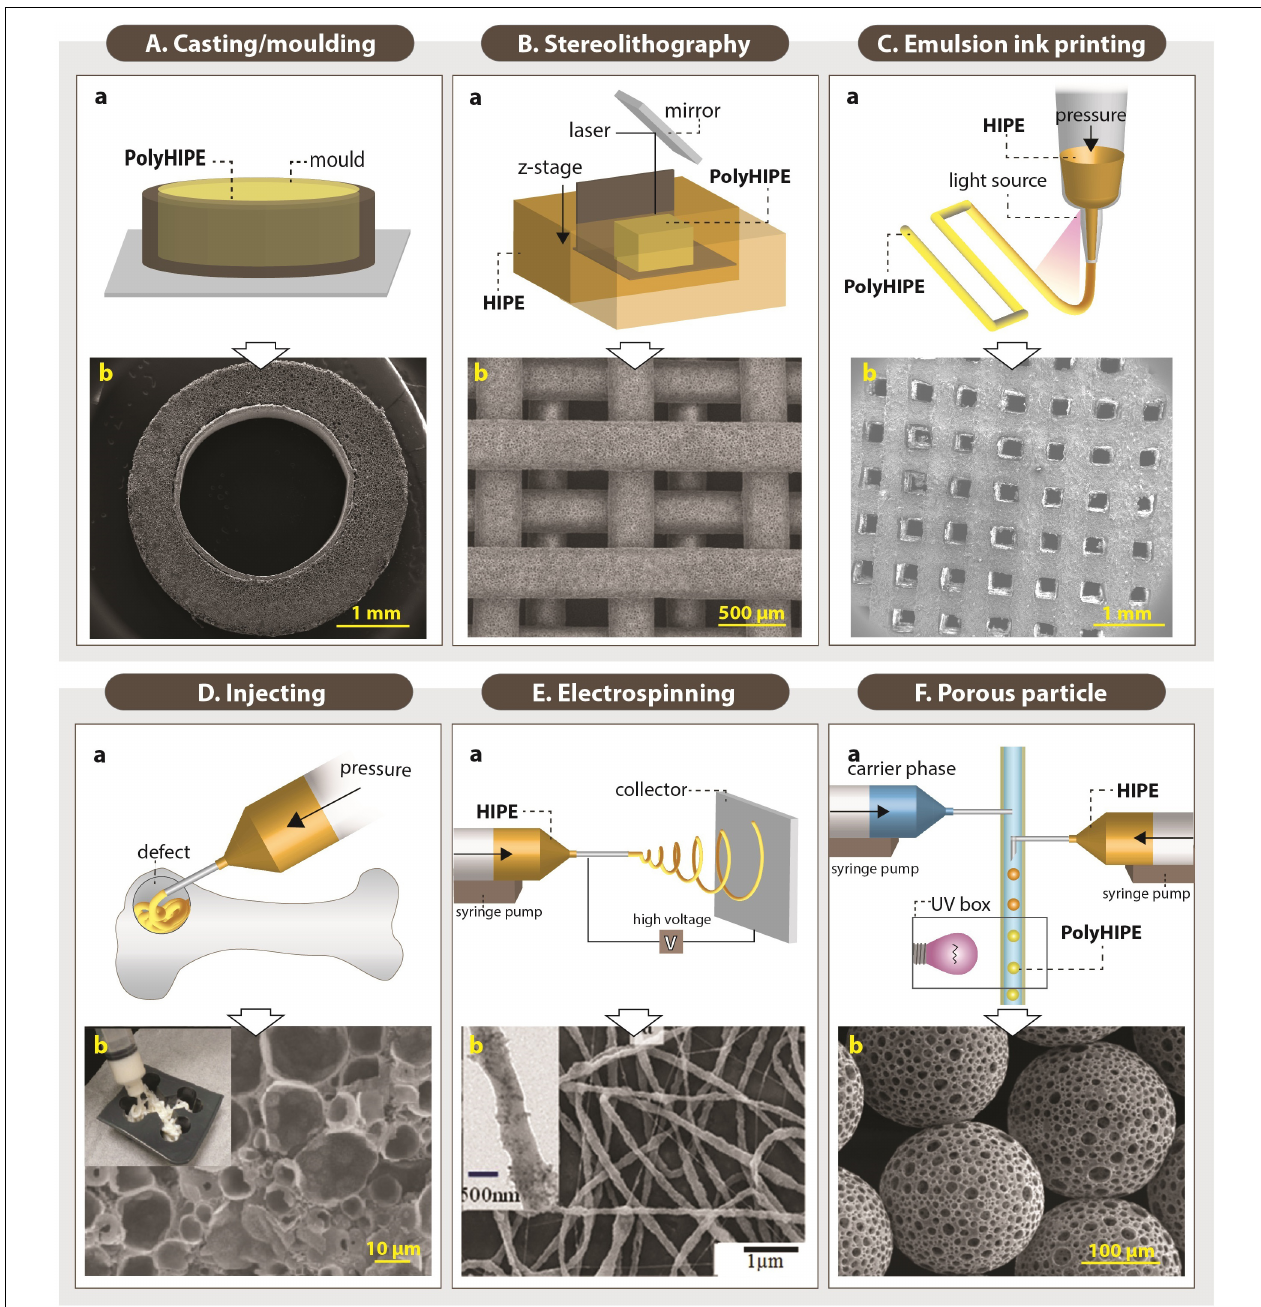
FIGURE 10 | Setups of various fabrication routes of emulsion templated scaffolds (Aa,Ba,Ca,Da,Ea,Fa) , and scanning electron microscopy images of these scaffolds (Ab,Bb,Cb,Db,Eb,Fb) . (Original images were cropped, and scale bars were added to enhance the figures). Images (Ab,Bb,Cb,Fb) were adapted from Dikici et al. (2020a), Owen et al. (2016), Aldemir Dikici et al. (2020), and Paterson et al. (2018) respectively, under The Creative Commons License. Image (Db) was adapted with permission from Moglia et al. (2011), Copyright 2011 American Chemical Society. Image (Eb) was adapted with permission from Samanta et al. (2017a), Copyright 2017 American Chemical